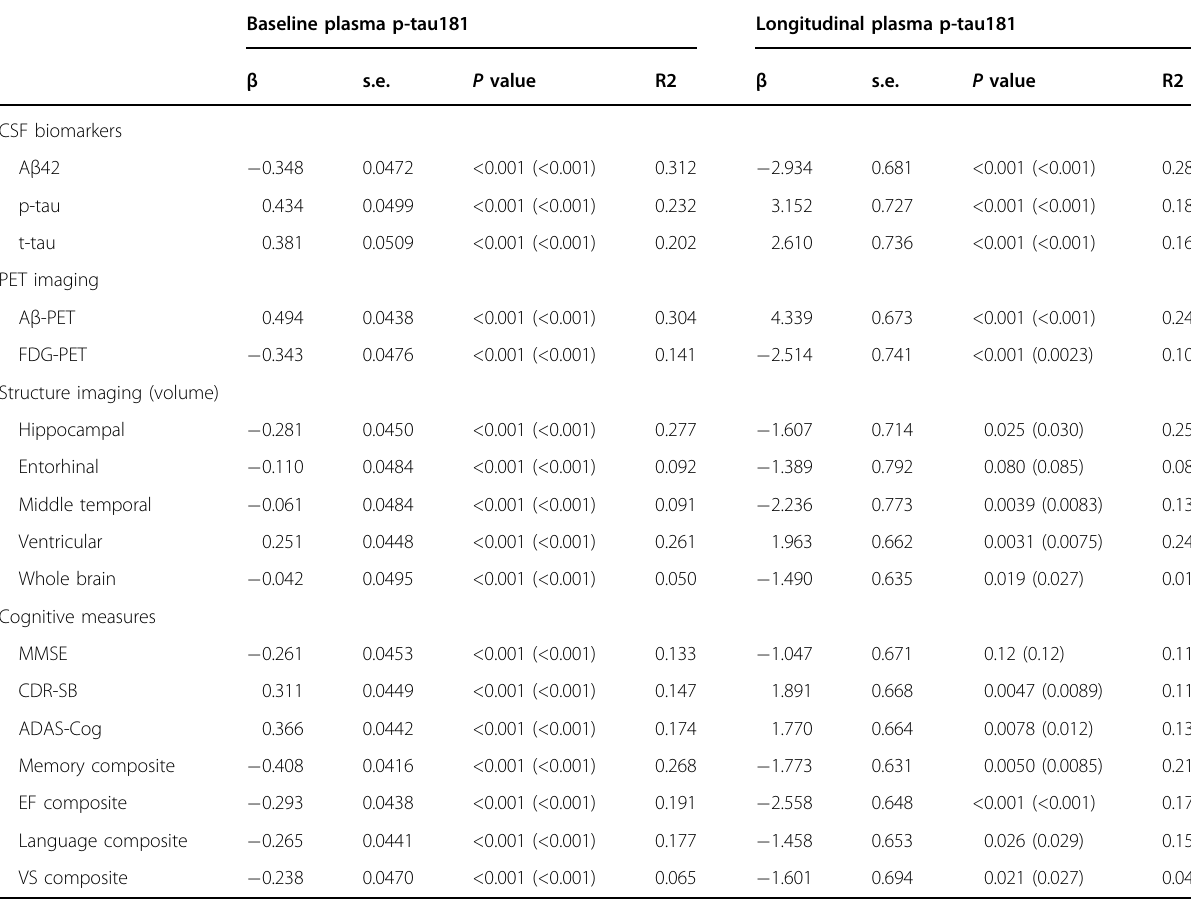
Table 2 Associations of baseline AD-related hallmarks with baseline and longitudinal changes of plasma